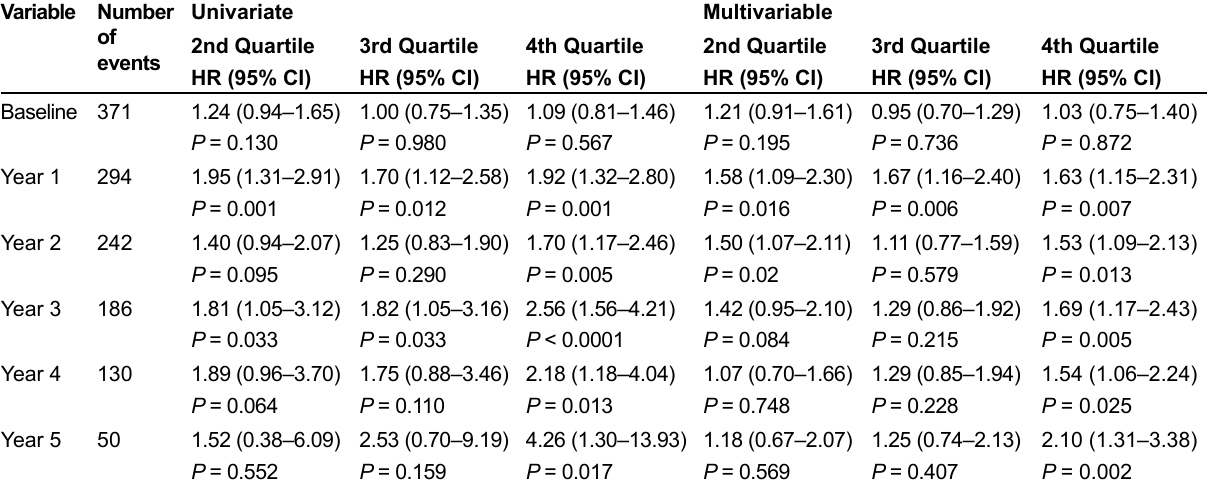
Table 2. Univariate and multivariable Cox models for the prediction of subsequent new-onset AF by SUA quartiles using first quartile as reference